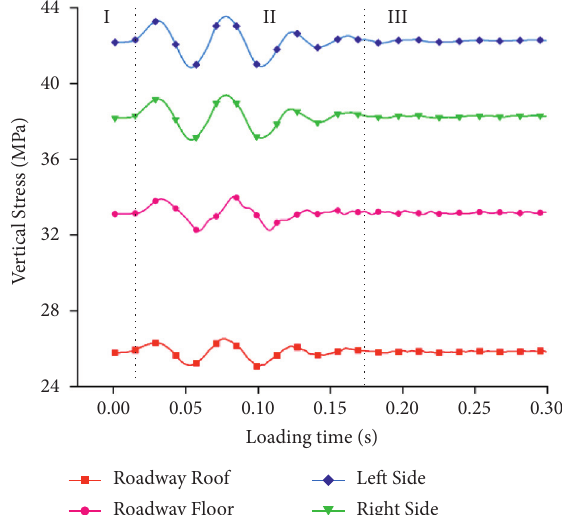
Figure 15: Characteristics of the dynamic load response of the roadway in the isolated coal pillar